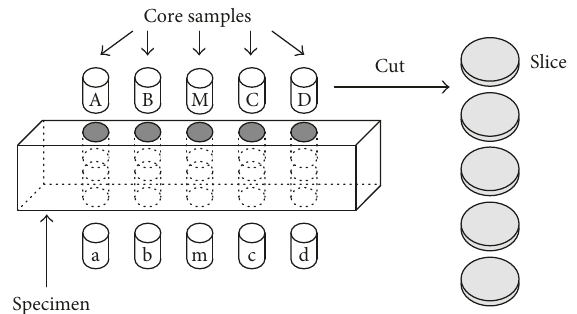
Figure 4: Schematic diagram of core sample drilling and sheet